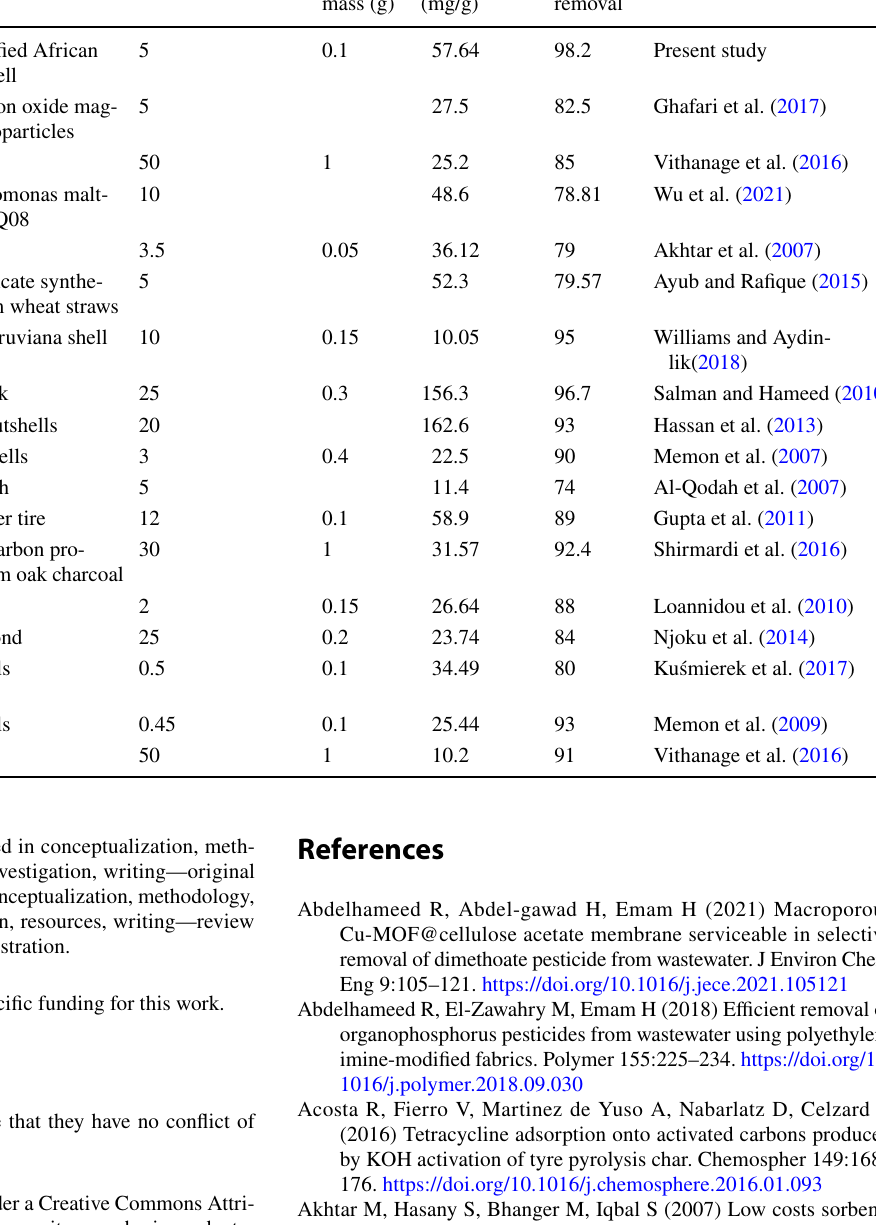
Table 6 Comparison of KOHAWS with other adsorbents for pesticides removal